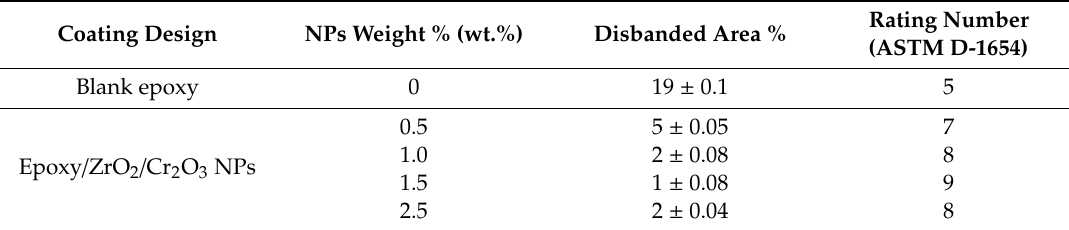
Table3. SaltsprayresistanceofZrO 2 / Cr 2 O 3 epoxynanocompositescoatingfilmsatdi ff erentZrO 2 / Cr 2 O 3 NPs loading after exposure time 720